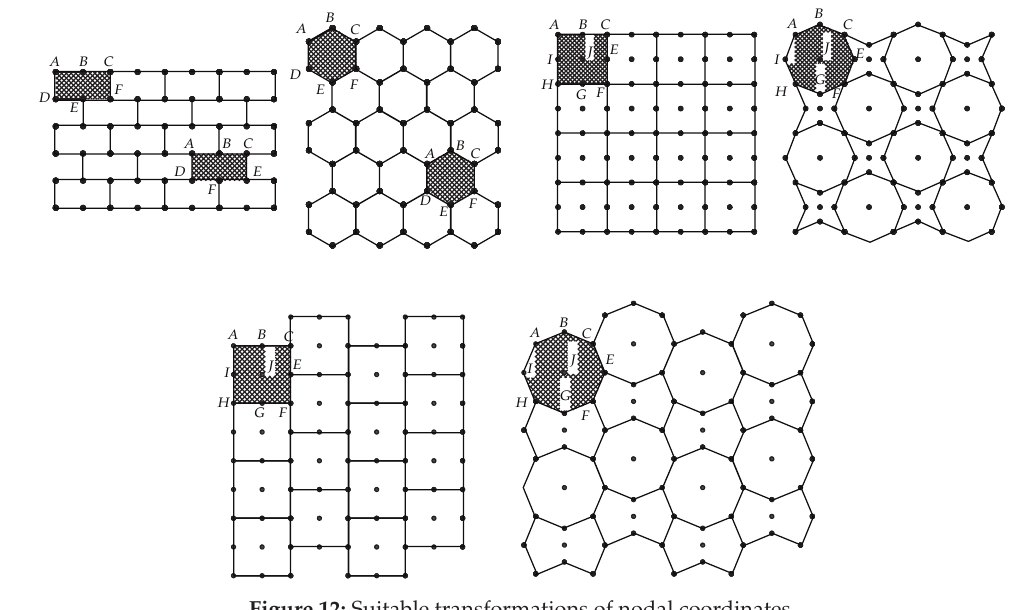
Figure 12: Suitable transformations of nodal coordinates.